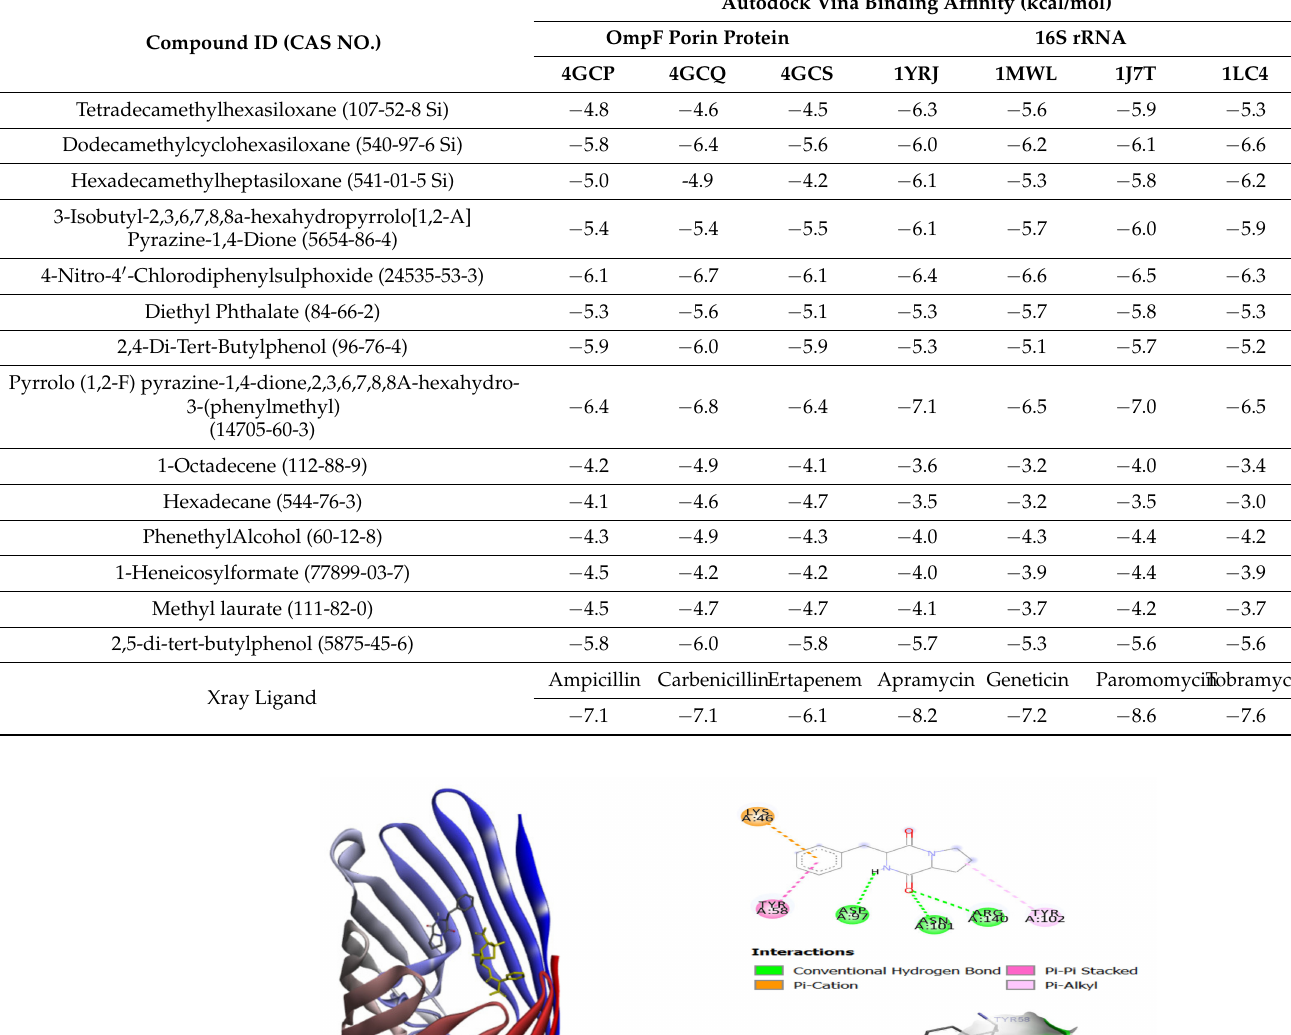
Table 2. Docking energy values ( ∆ G in kcal/mol) of the selected compound. The highlighted compounds were bound well over the selected investigation with the targets.